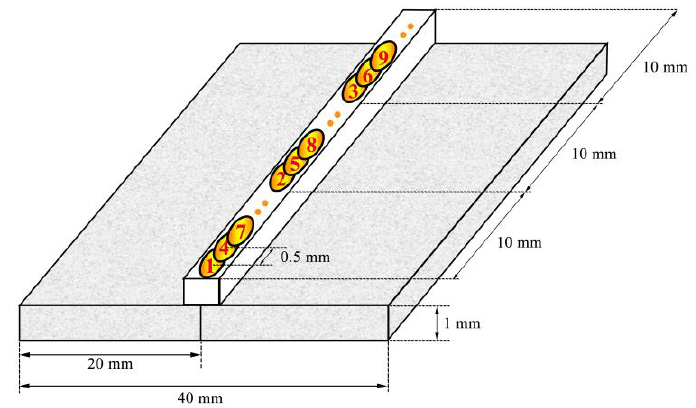
Figure 1. Schematic illustration of welding strategies.